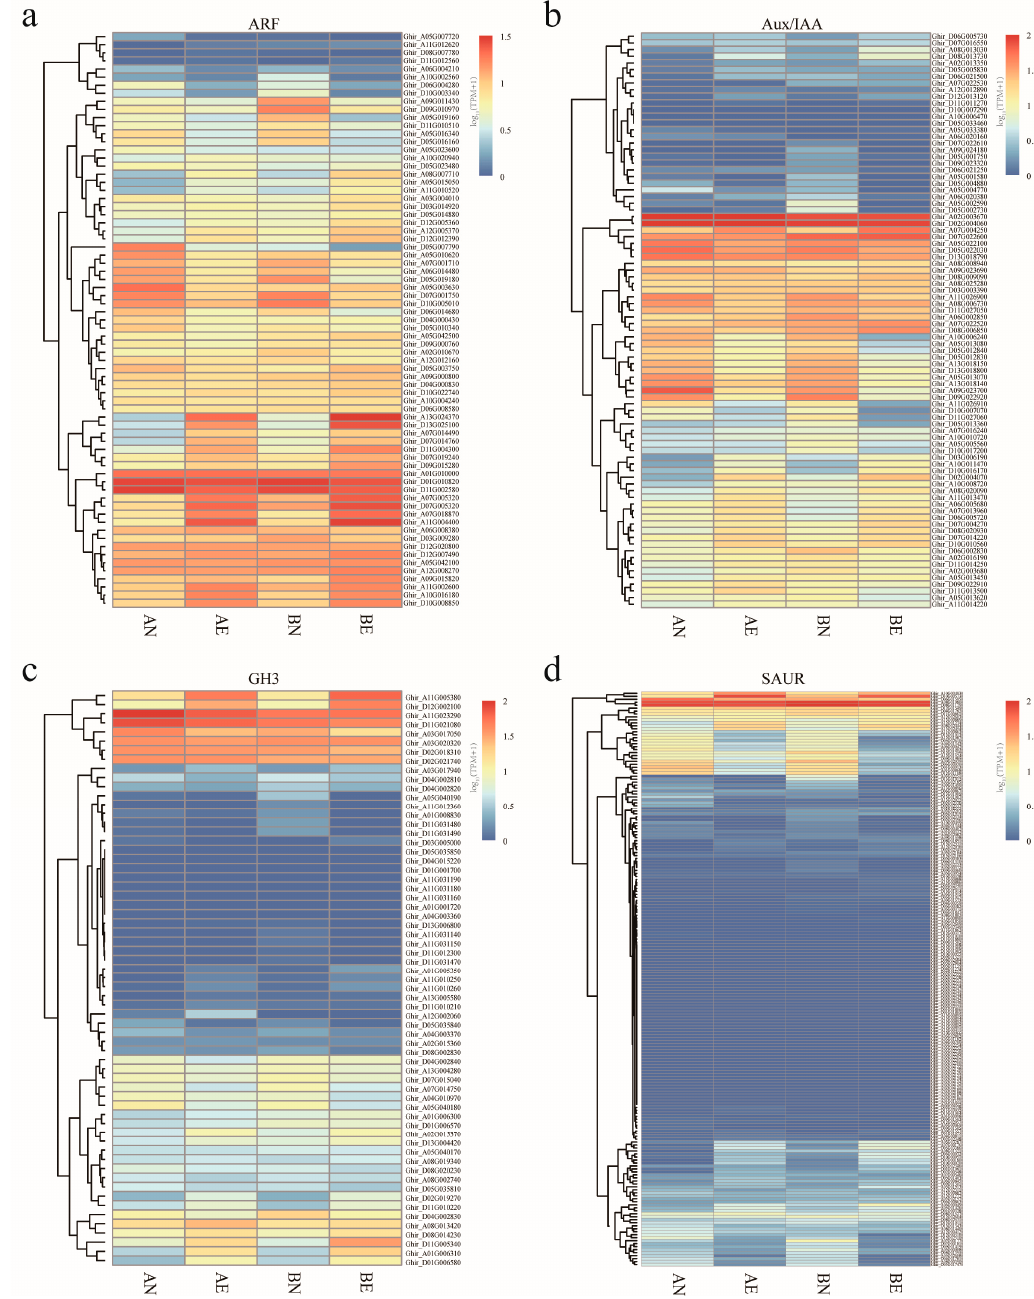
Figure 3. Expression profiles of ARF ( a ), Aux / IAA ( b ), GH3 ( c ), and SAUR ( d ) genes during the acquisition of the embryogenic ability of upland cotton callus from NEC to EC. The heatmaps were drawn based on log 10-transformed TPM values of genes derived from the RNA sequencing analysis. AN and AE represent the NEC and EC of the recalcitrant embryogenic cultivar CCRI12, respectively and BN and BE represent the NEC and EC of highly embryogenic cultivar CCRI24, respectively.